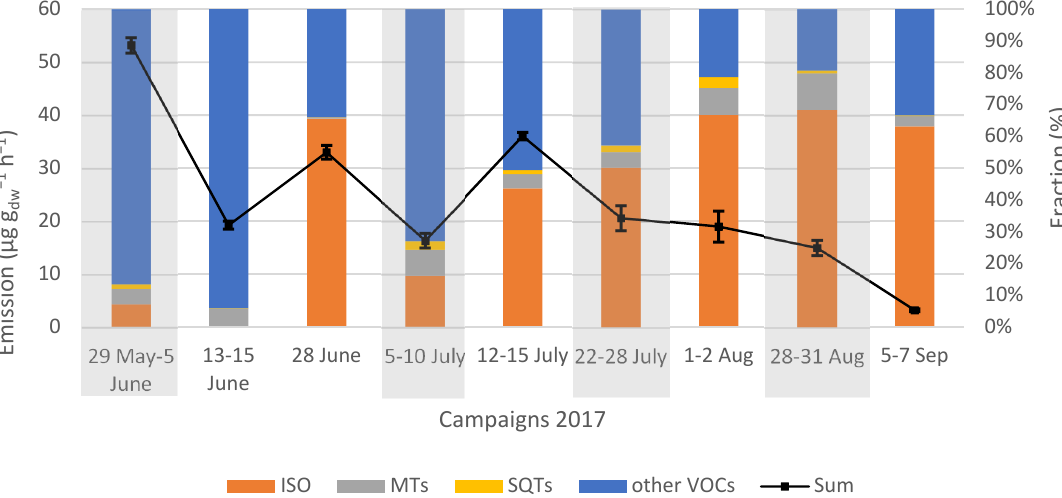
Figure 2. Total biogenic volatile organic compound (BVOC) emissions (black square, mean ± standard deviation, µg g dw − 1 h − 1 , n = 11–56), and the fractions of isoprene (ISO), monoterpenes (MTs), sesquiterpenes (SQTs) and other volatile organic compounds (other VOCs) throughout the season for each campaign. Campaigns performed on plots 1 and 2 (grey boxes) were done from 29 May to 5 June, 5 to 10 July, 22 to 28 July and 28 to 31 August. Campaigns performed on plots 3 and/or 4 were done from 13 to 15 June, on 28 June, from 12 to 15 July, from 1 to 2 August and from 5 to 7 September.